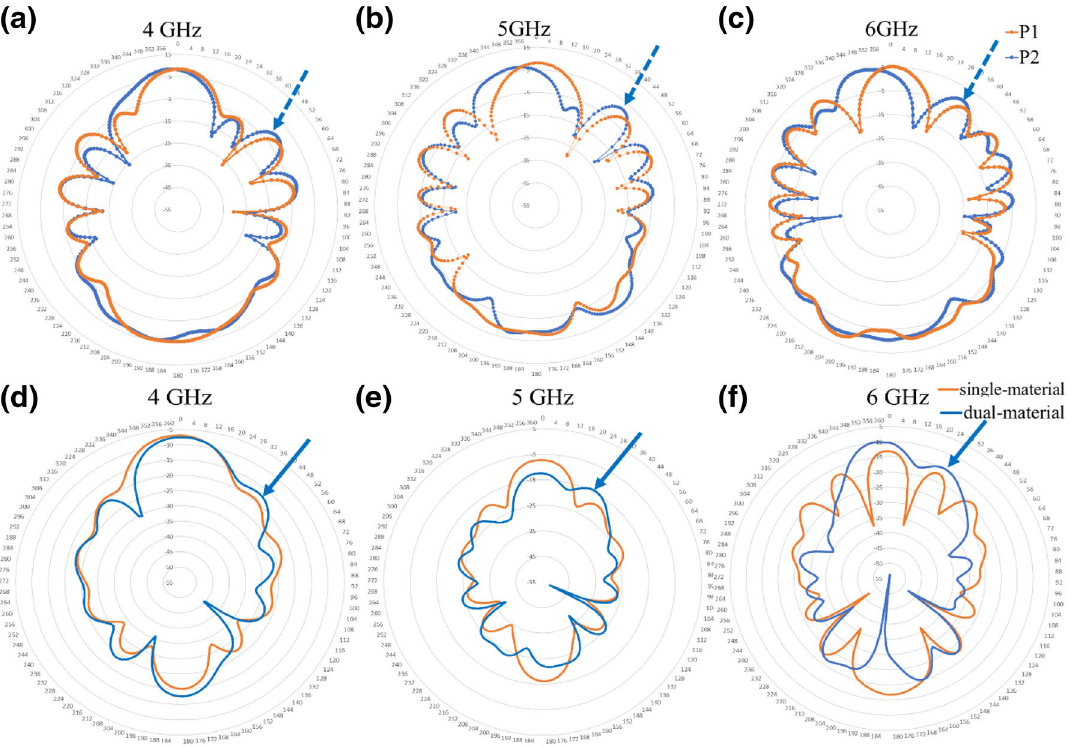
Figure 5. Experimental ( a – c ) FF electric field radiation pattern for prototypes P1 (orange) and P2 (blue) with numerically simulated FF radiation pattern ( d – f ) for single-material (orange) and dual-material (blue) systems at illumination frequencies of 4, 5 and 6